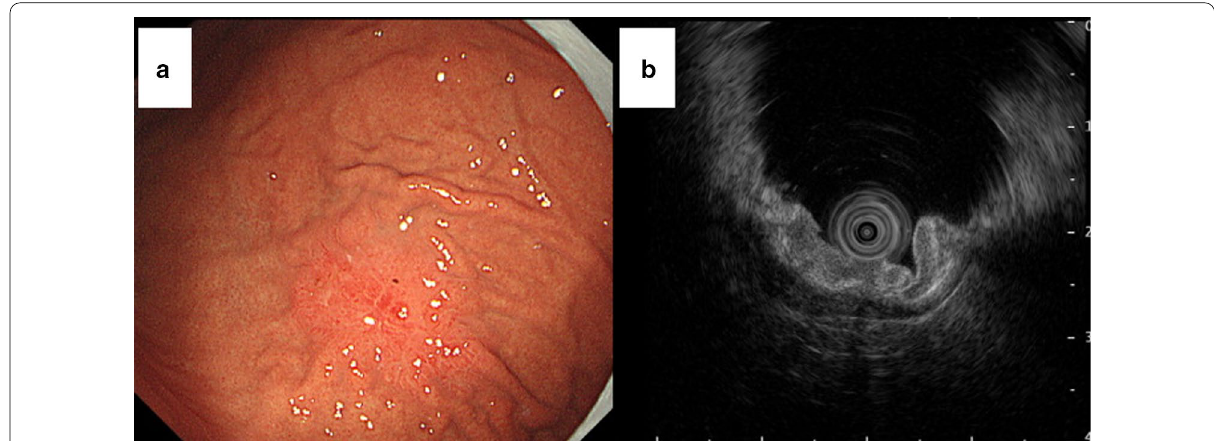
Fig. 1 Endoscopic findings. a An irregular depressed lesion with convergence of folds of 25 mm in size at the greater curvature of the upper gastric body. b EUS showed that the tumor was located mainly at the second layer with partial compression of the third layer